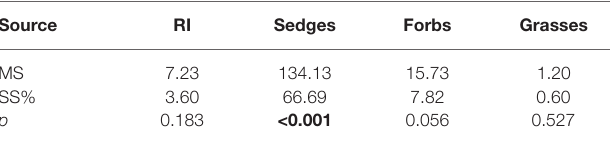
TABLE 2 | Integrative effects of species richness (RI), the temporal stability of AGB of sedges (Sedges), the temporal stability of AGB of forbs (forbs), the temporal stability of AGB of grasses (Grasses) on the temporal stability of plant community AGB in the dry and wet conditions based on the general linear models